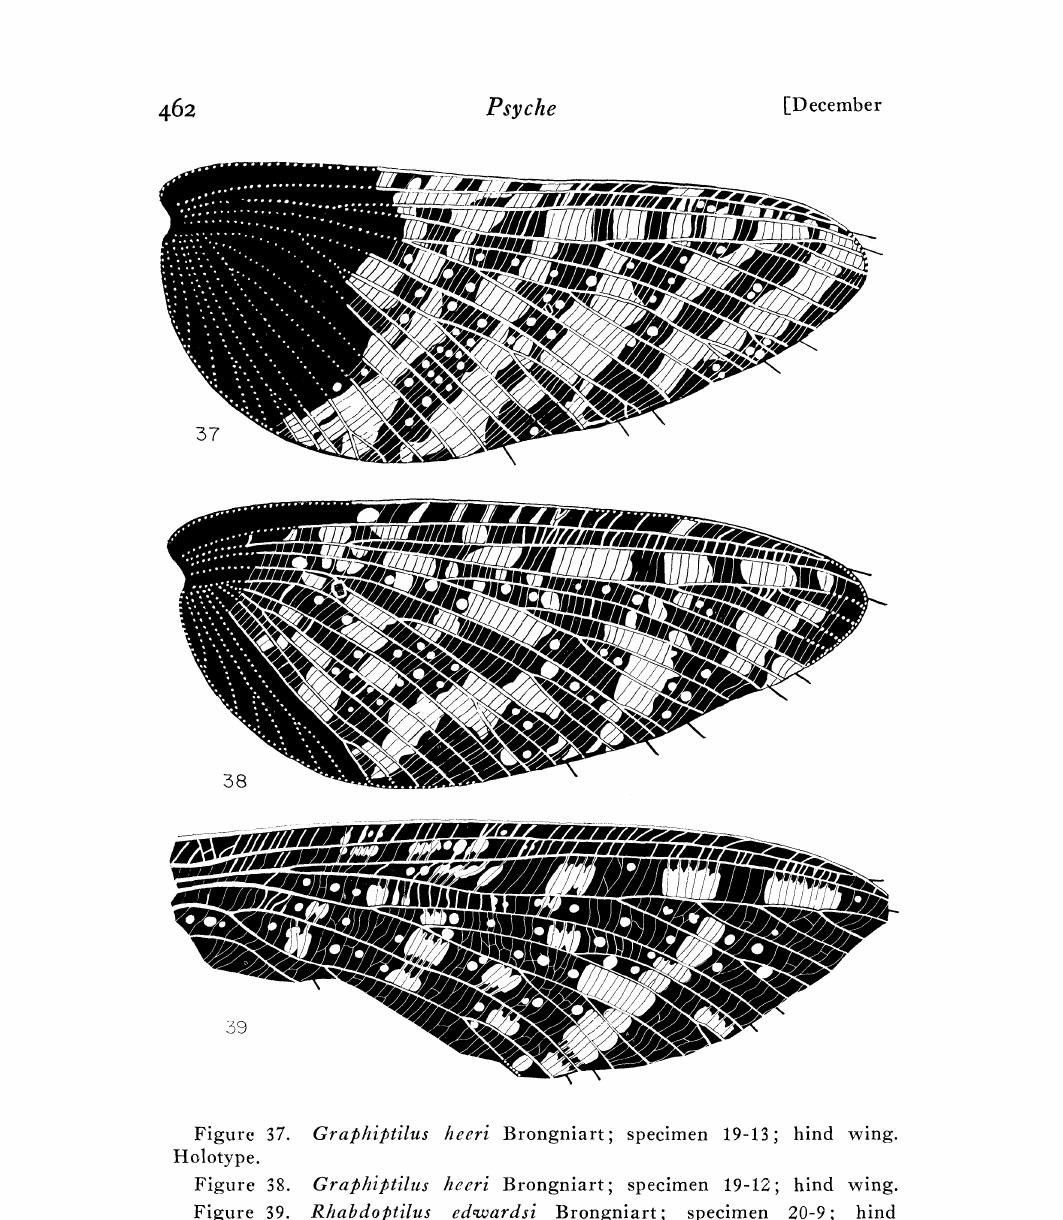
Figure 37. Graphiptilus heeri Brongniart; specimen 19-13; hind wing. Holotype. Figure 38. GraI)hiptilus heeri Brongniart; specimen 19-12; hind wing. Figure 39. RhabdoDtilus edardsi Brongniart; specimen 20-9; hind wing.